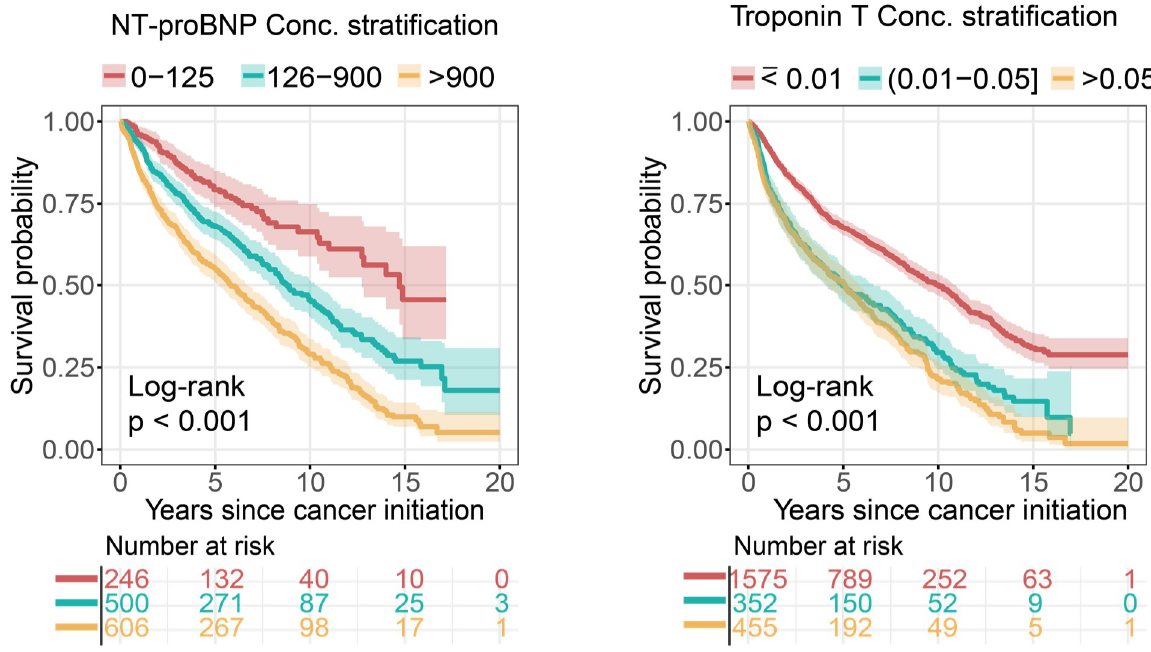
Fig 6. KM analysis of NT-proBNP and Troponin T in cancer patients. The threshold of different NT-proBNP (pg/mL) and Troponin T ( μ g/L) levels were used based on published clinical guidelines. The log-rank test with the BH adjustment [42] was used for survival comparisons among 3 groups. The shadow represents 95% CIs. p -value was computed by log-rank test. BH, Benjamini and Hochberg; CI, confidence interval; KM, Kaplan–Meier; NT-proBNP, NT-proB-type Natriuretic Peptide.